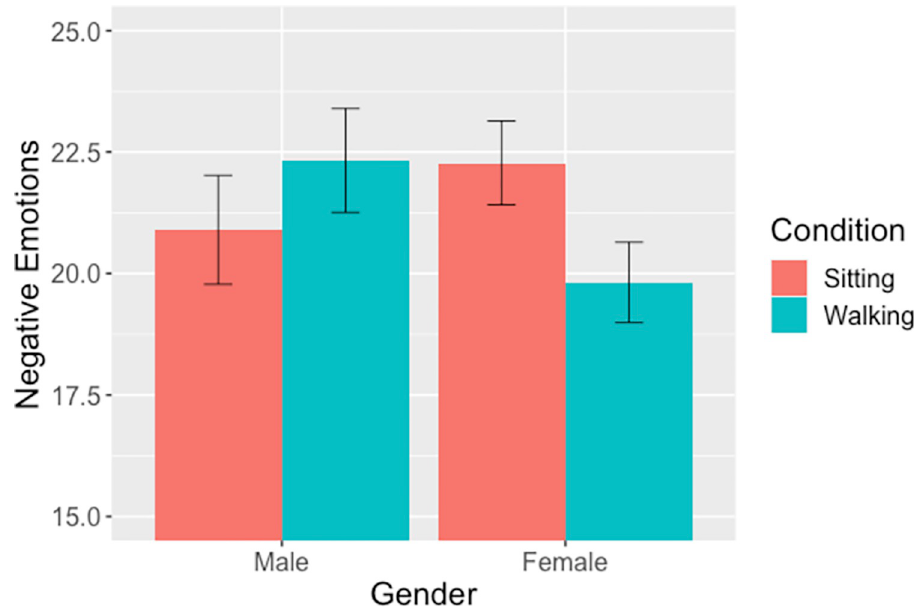
Fig 3. Negative Emotions x Condition x Gender. Note : The means reflect estimated marginal means. Error bars reflect standard errors of the mean.